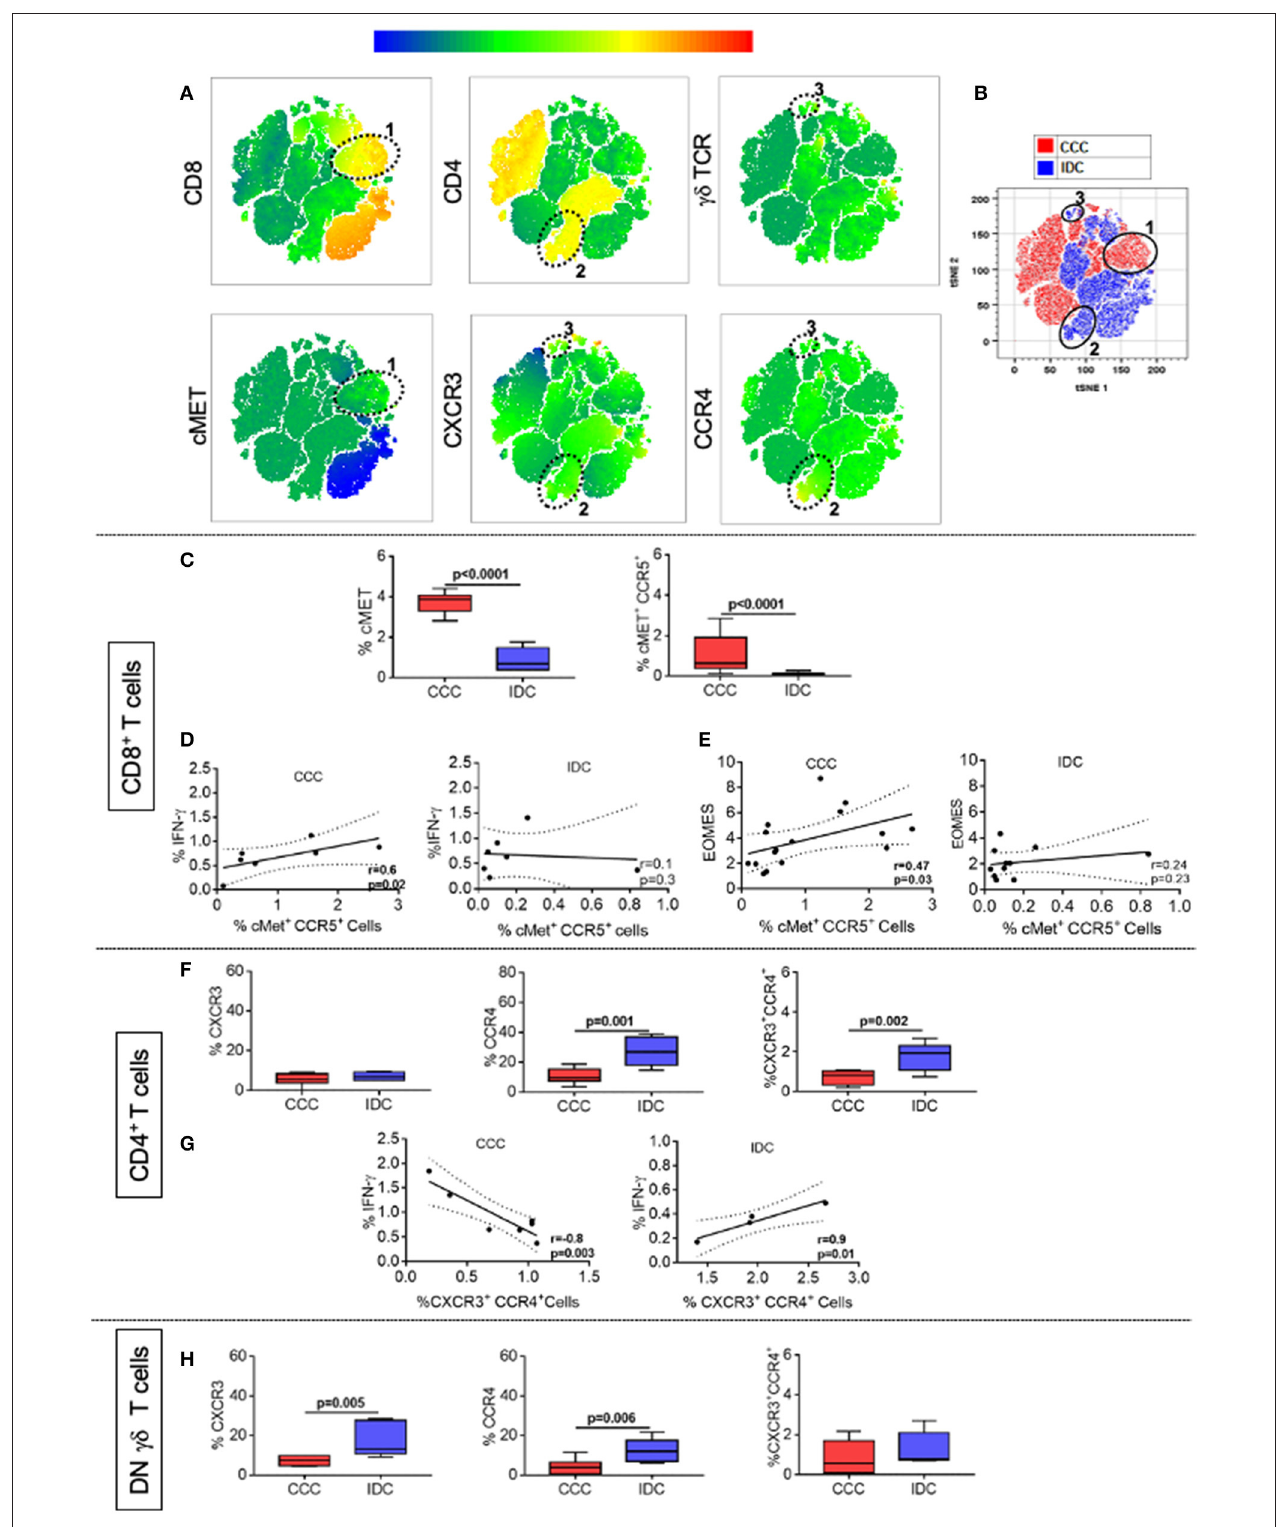
FIGURE 6 | CCR4 and CXCR3 expression reveals distinct recruitment potential between cardiomyopathies. (A) Representation of t-distributed stochastic neighbor embedding (t-SNE) using the expression density of CD4, CD8, cMET, TCR gamma-delta, CXCR3, and CCR4, with emphasis on clusters 1, 2, and 3 shown by the ellipses. Cluster 1 shows the colocalization between cMET and CD8 expression, while clusters 2 and 3 demonstrate the expression of CXCR3 and CCR4 by CD4 +